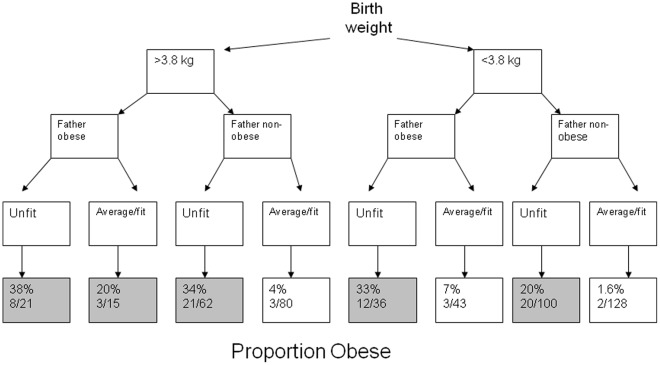
Obesity levels by risk factor.